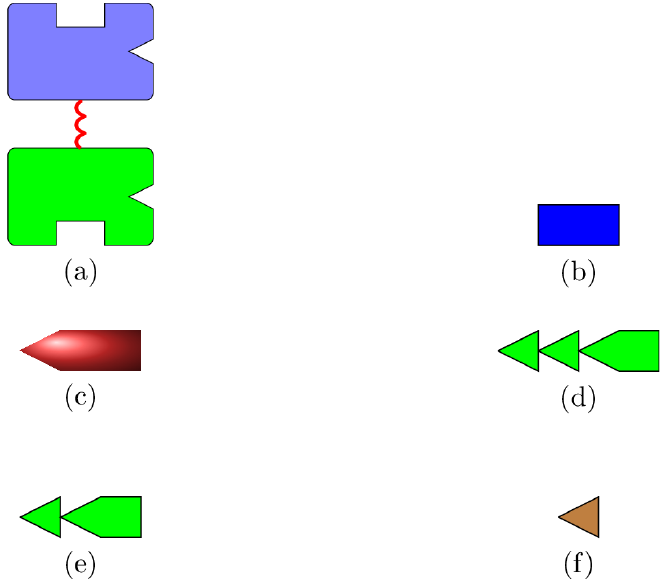
Figure 1. Schematic representations for hexokinase, glucose, glucose-6-phosphate, adenosine triphos- phate ( ATP ), adenosine diphosphate ( ADP ), and inorganic phosphate ( P i ). ( a ) The hexokinase I enzyme. The C - and N -domains are coloured green and light blue, respectively. (cid:116) : binding sites for glucose; ∨ : binding sites for ATP , G 6 P , and P i . ( b ) Glucose. ( c ) Glucose-6-phosphate. ( d ) Adenosine triphosphate ( ATP ). ( e ) Adenosine diphosphate ( ADP ). ( f ) Inorganic phosphate ( P i ).